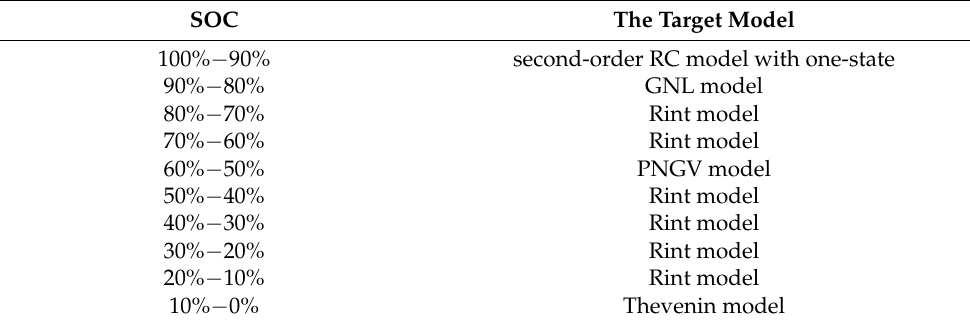
Table 4. Selection of different SOC fragment models. SOC The Target Model 100% −